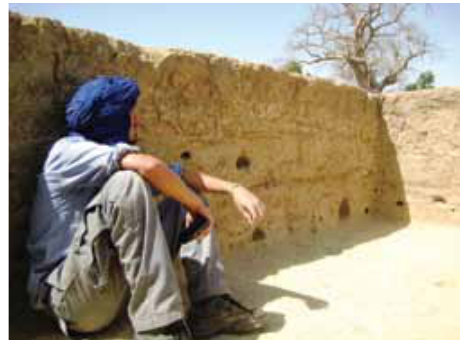
Fig. 4: Nick Gestrich contemplating Unit A profiles; note the thin lines of gravel pavements.